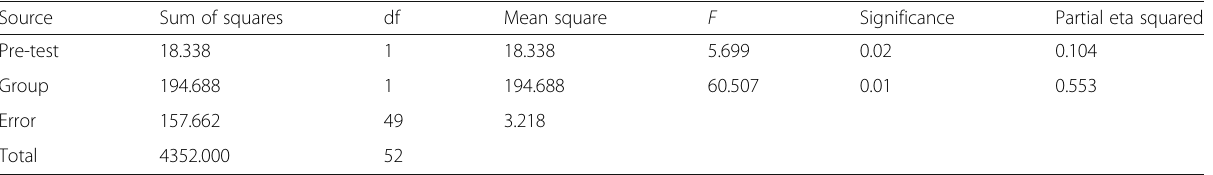
Table 6 Result for ability to respond to others between the two intervention groups Source Sum of squares